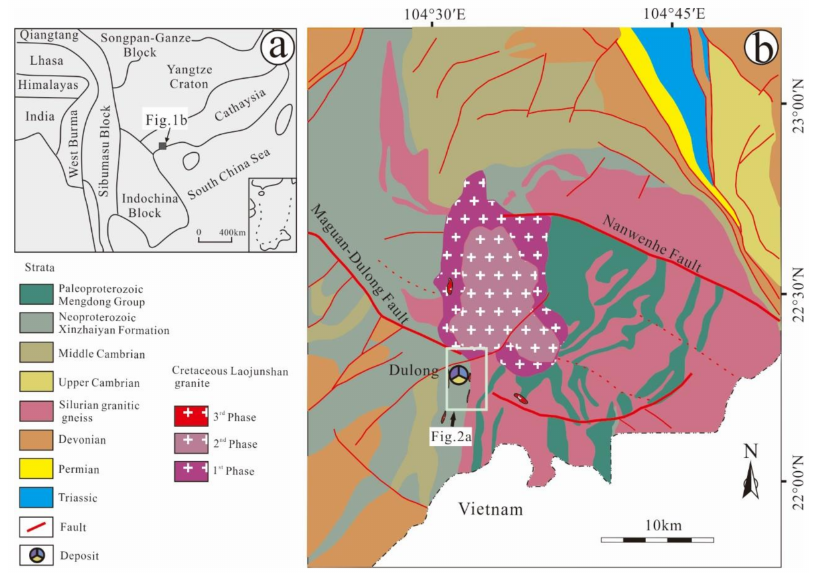
Figure 1. ( a ) Simplified structural map showing the location of the study area. ( b ) Geological sketch map of the Laojunshan Metamorphic Core Complex, Yunnan Province, China [22].